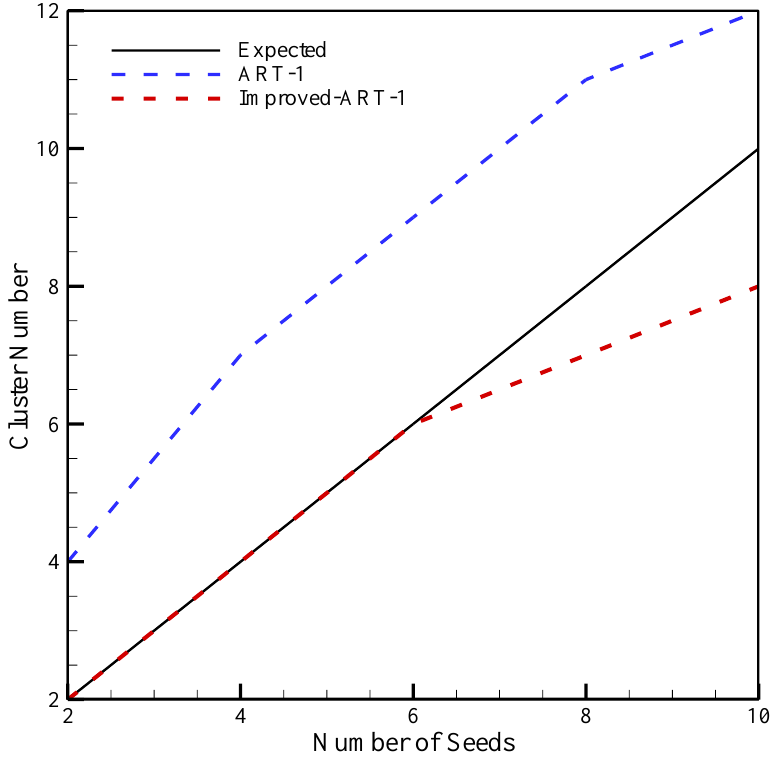
Figure 5. Comparative study between ART-1 and Improved-ART-1 with M1 as a function of number of seeds where the vigilance value is